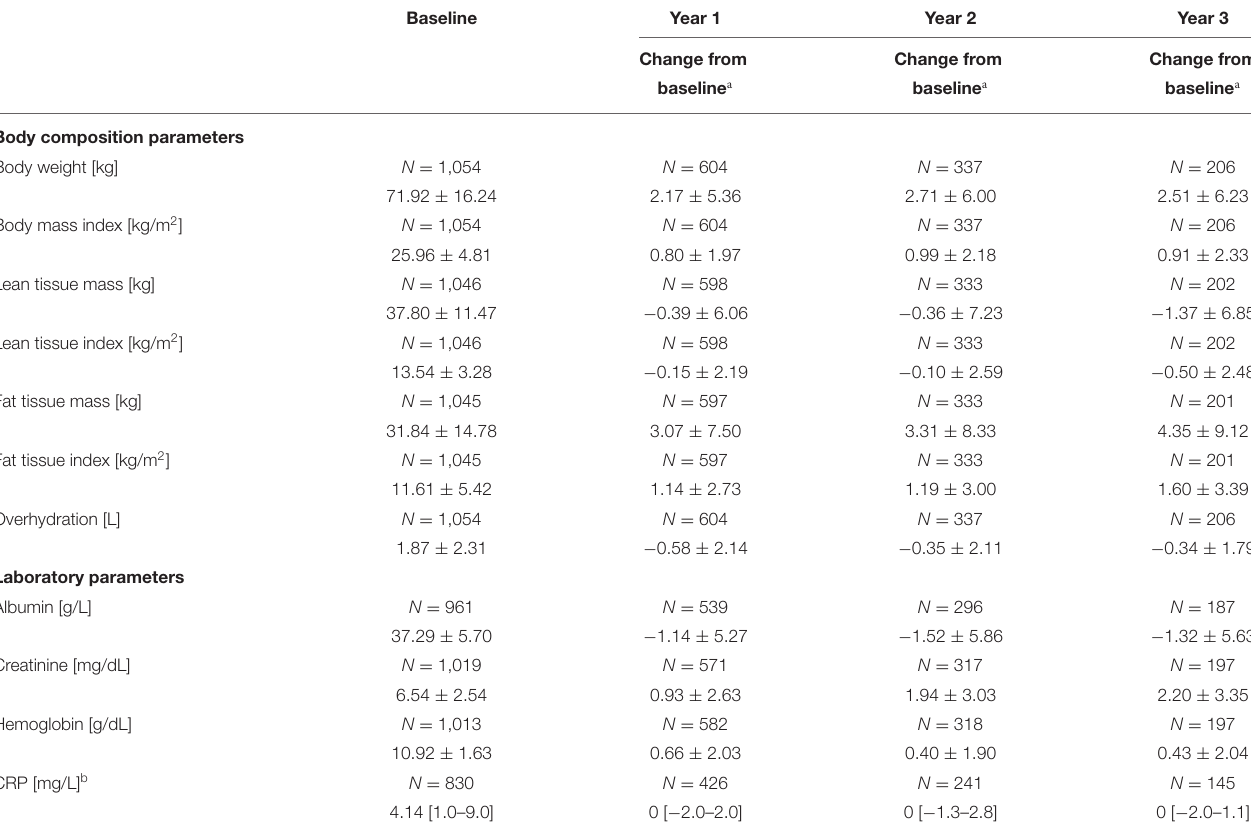
TABLE 3 | Course of nutritional parameters over time. Baseline Change from Change from Change from baseline a baseline a baseline